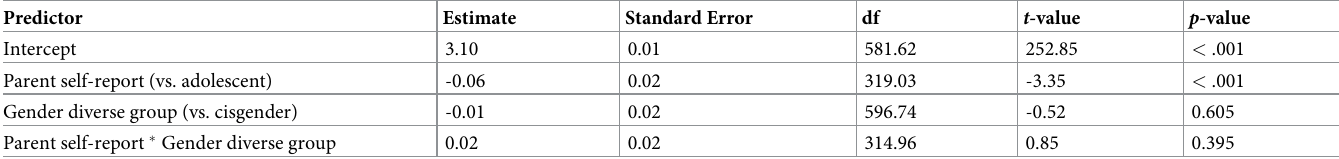
Table 6. Results from linear mixed-effect model predicting participants’ average gender stereotype endorsement scores. Reference group is cisgender adolescent self- report. Predictor